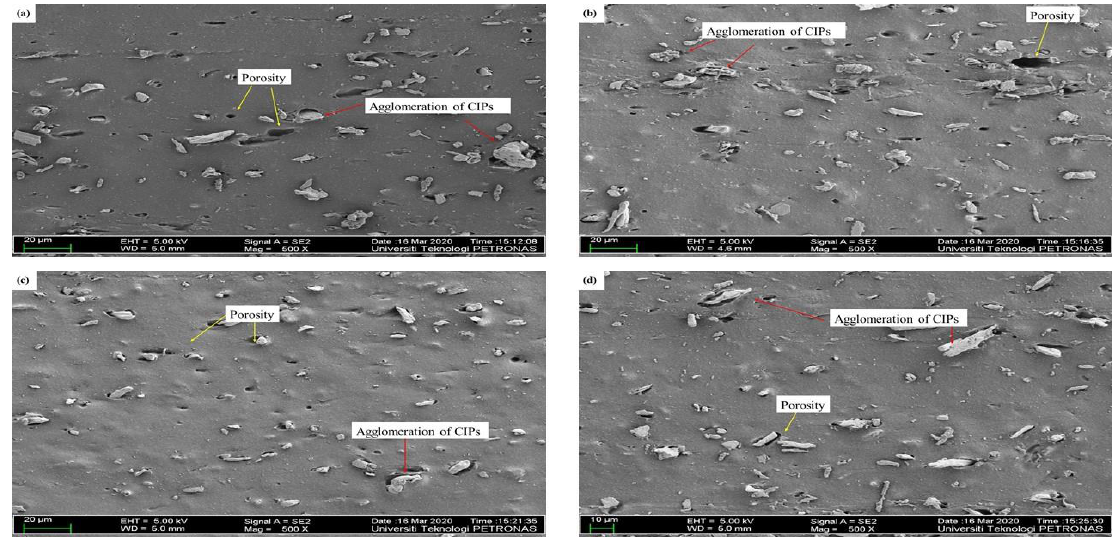
Figure 6. Microstructures of MREs for different ratios of PO:AO. ( a ) PO 1, ( b ) PO 2, ( c ) PO 3, and ( d ) PO 4.